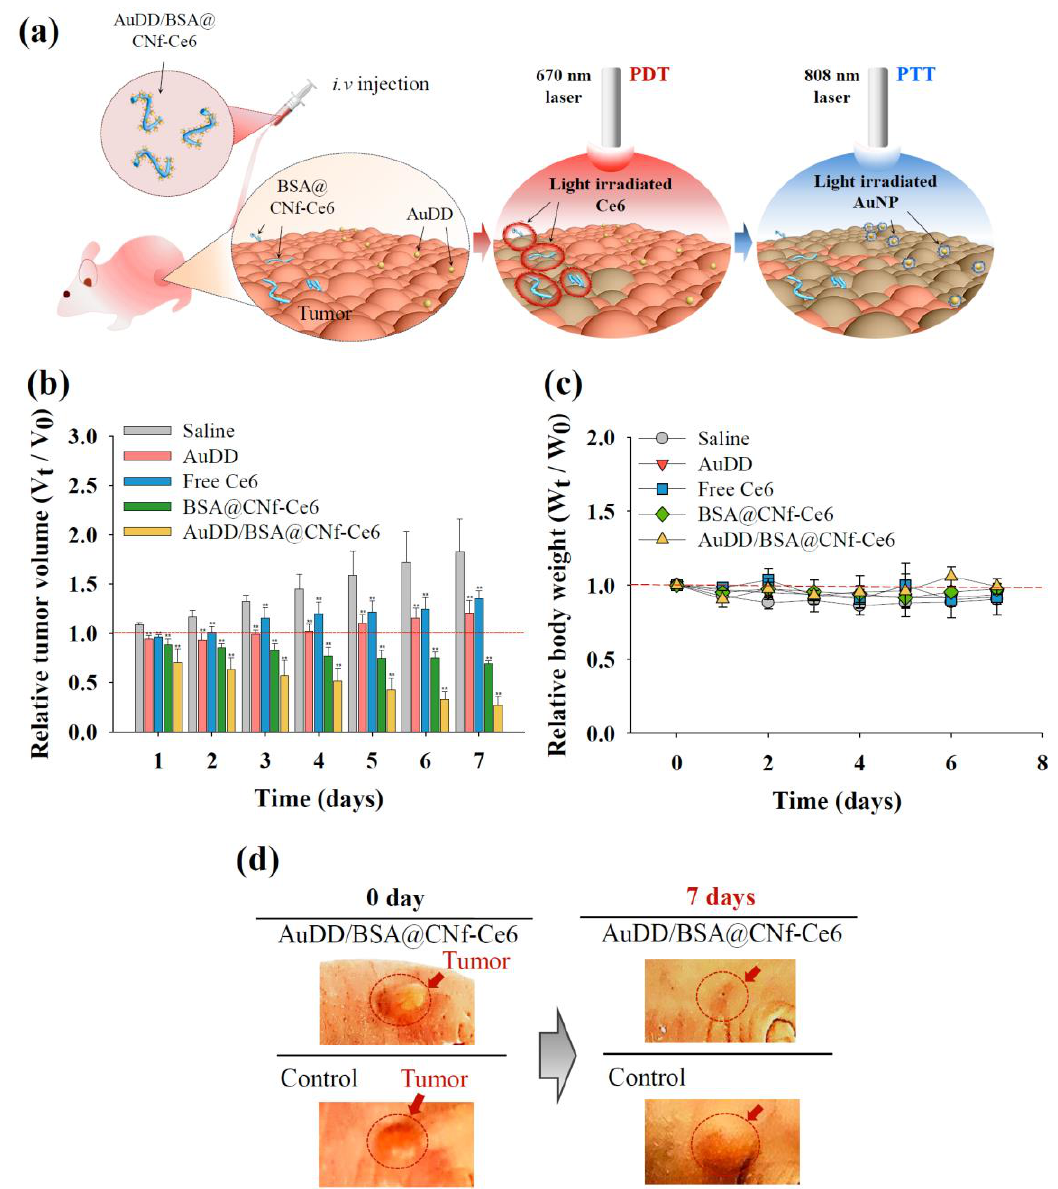
Figure 11. ( a ) Graphical strategy of AuDD/BSA@CNf-Ce6 for PDT/PTT dual therapy. ( b ) Relative tumor volume change ( V t / V 0 ) and ( c ) relative body weight change ( W t / W 0 ) of MDA-MB-231 tumor-bearing nude mice treated with saline (control), AuDD, free Ce6, BSA@CNf-Ce6, or AuDD/BSA@CNf-Ce6. Tumor sites were irradiated at a light intensity of 5.2 mW/cm 2 for 40 min using a 670 nm laser source at 8 h post-injection (PDT treatment), then at a light intensity of 2 W/cm 2 using an 808 nm light source for 5 min (PTT treatment) (mean ± SD, n = 5, ** p < 0.01 compared to saline). ( d ) Optical photographs of MDA-MB-231 tumor-bearing nude mice after 7 d of injection. Tumor sites are indicated by the dashed